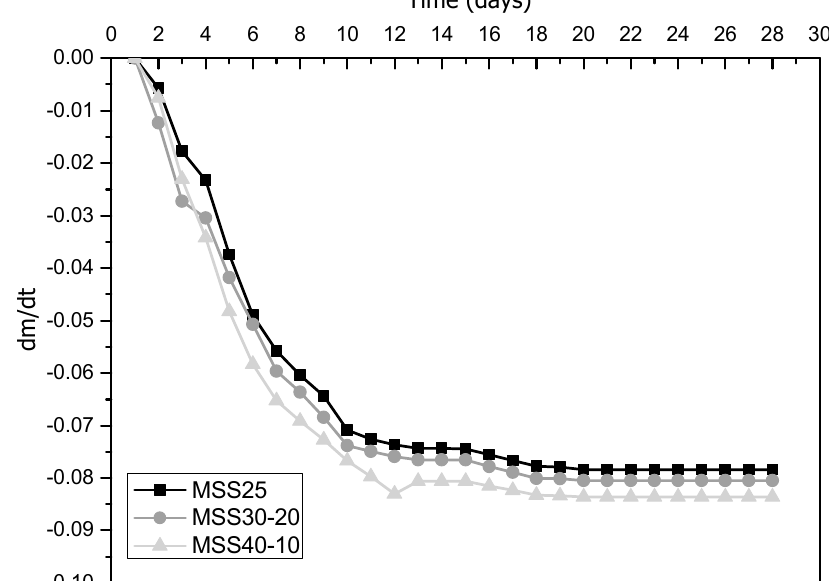
Figure 7. Weight change rate of hardened mortars.